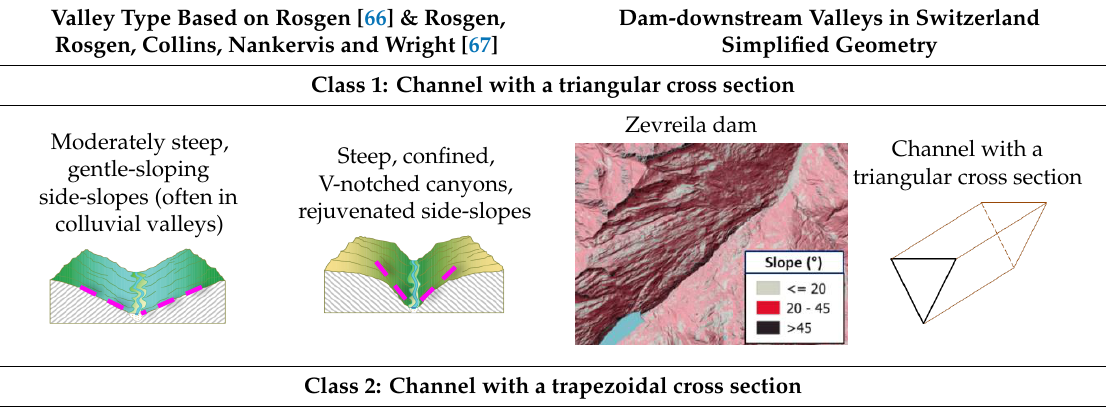
Table 1. Classification of the valleys downstream of 14 concrete arch hydropower dams in Switzerland.